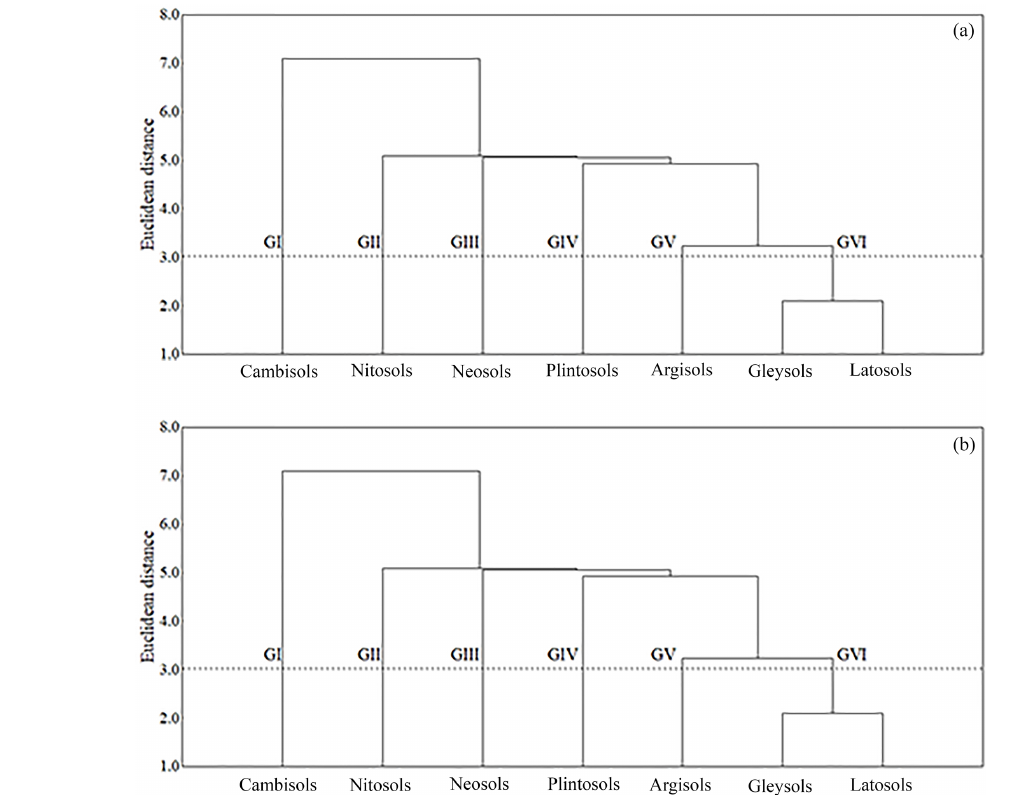
Figure 10. Cluster analysis of the classes of soils represented in the state of Pará, in the surface layer (a) and subsurface layer (b) .